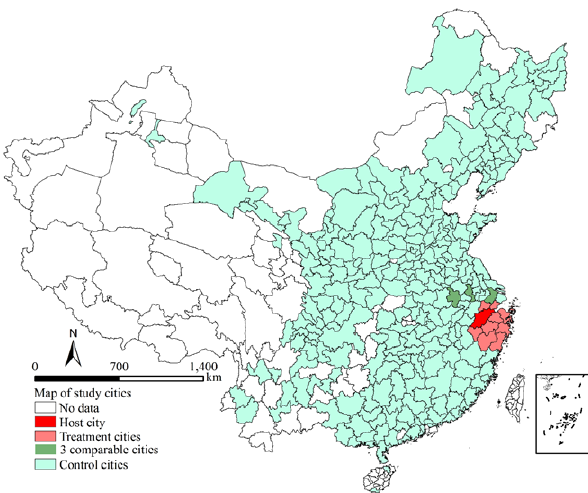
Figure 1. Map of study cities